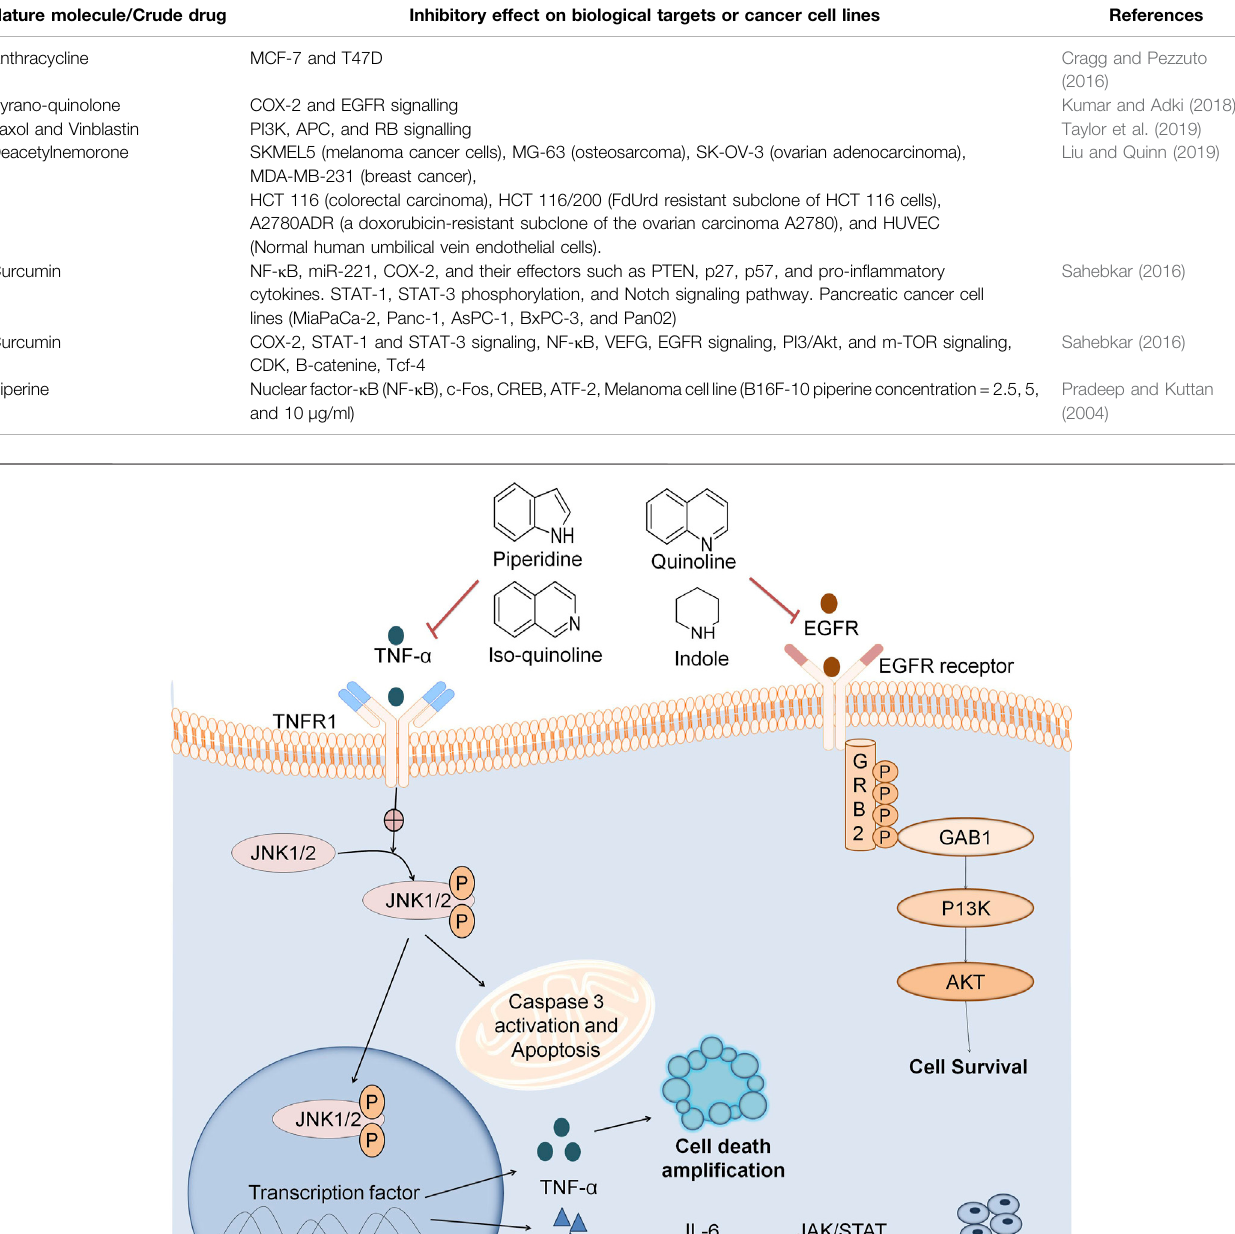
Frontiers in Pharmacology |